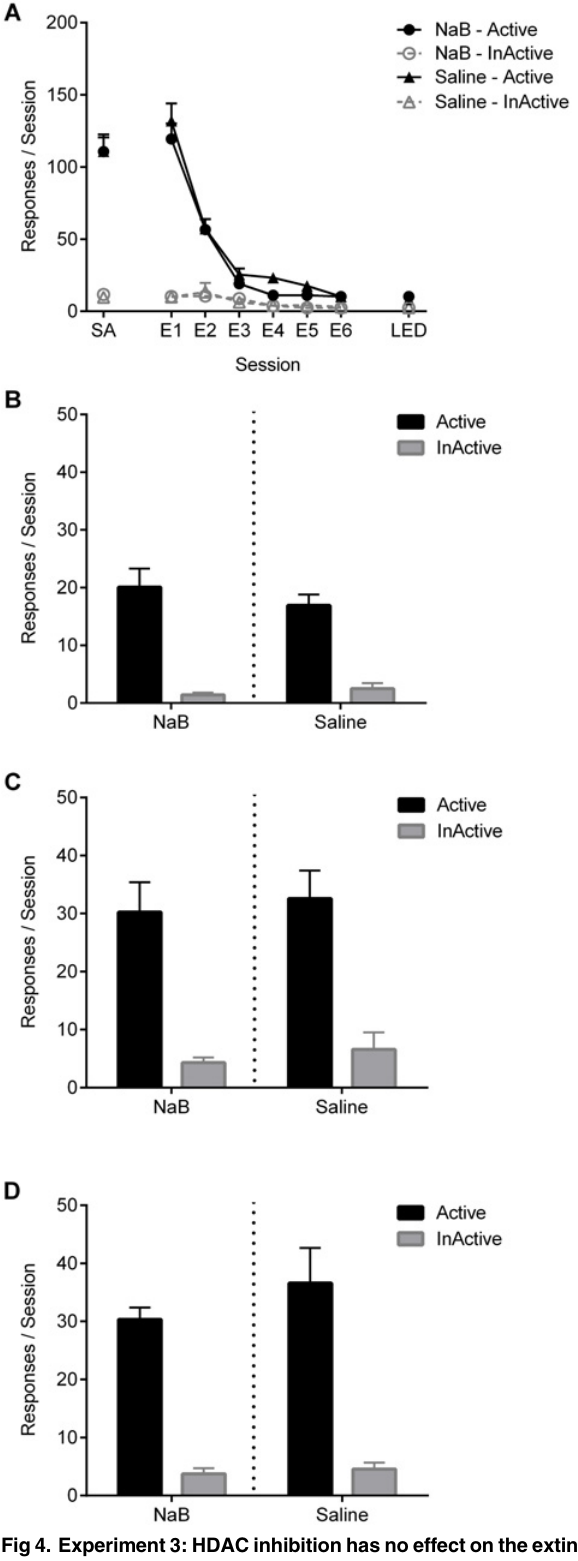
Fig 4. Experiment 3: HDAC inhibition has no effect on the extinction and reinstatement of sucrose- seeking. (A) Active and inactive responses during acquisition of sucrose self-administration (SA; average of the last 3 sessions) and the first six days (E1 – E6) and last day (LED) of extinction for rats treated with